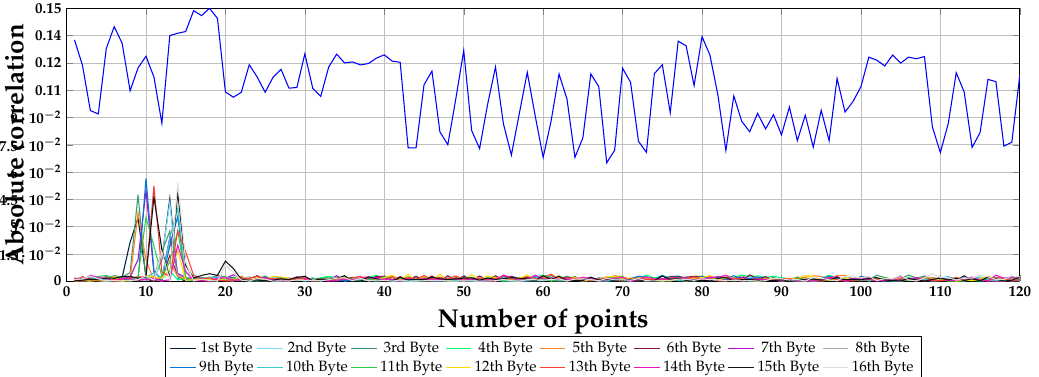
Figure 5. A trace for the DEA algorithm.